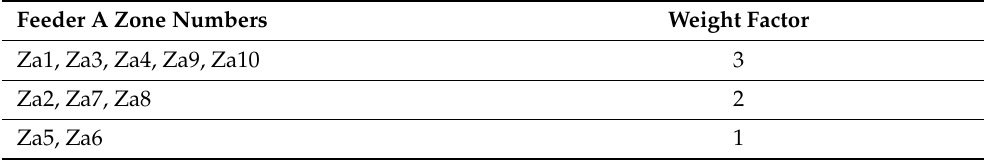
Table 2. Weight factors for feeder “A”